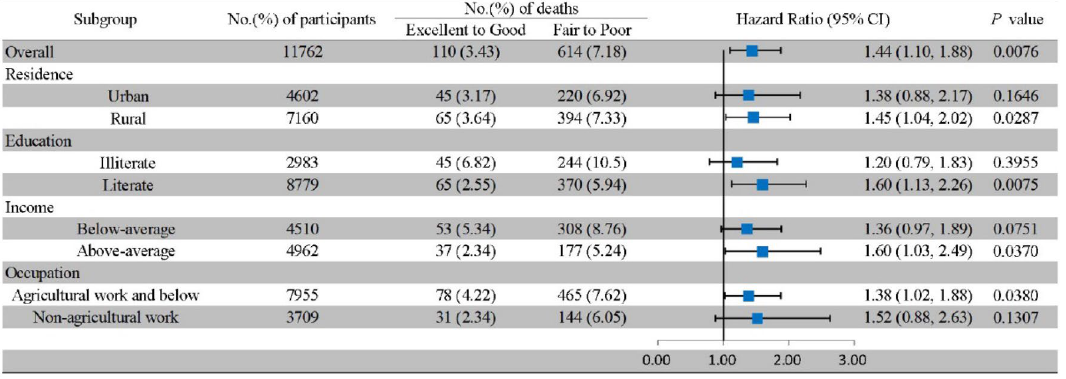
Figure 3. Stratified analyses of SES factors in the association of SRH with all-cause mortality. Notes Model was adjusted for age, sex, smoking status, drinking status, BMI, hypertension, Emotional, nervous, or psychiatric problems (ENP), dyslipidemia, diabetes, heart problems, cancer, chronic lung disease, memory-related disease, kidney disease, liver disease, arthritis, digestive disease and asthma, living place, education status and income